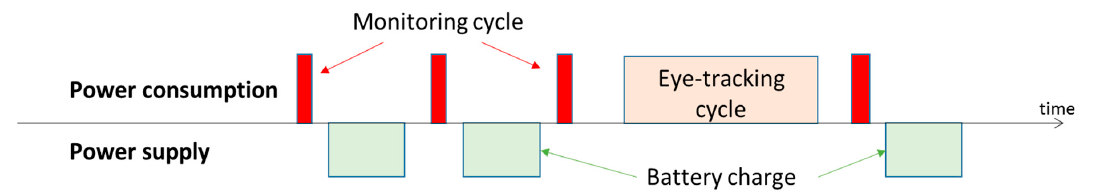
Figure 2. Cycles of use and the resulting cycle of charge and consumption. Table 1. Smart contact lens energy budget.